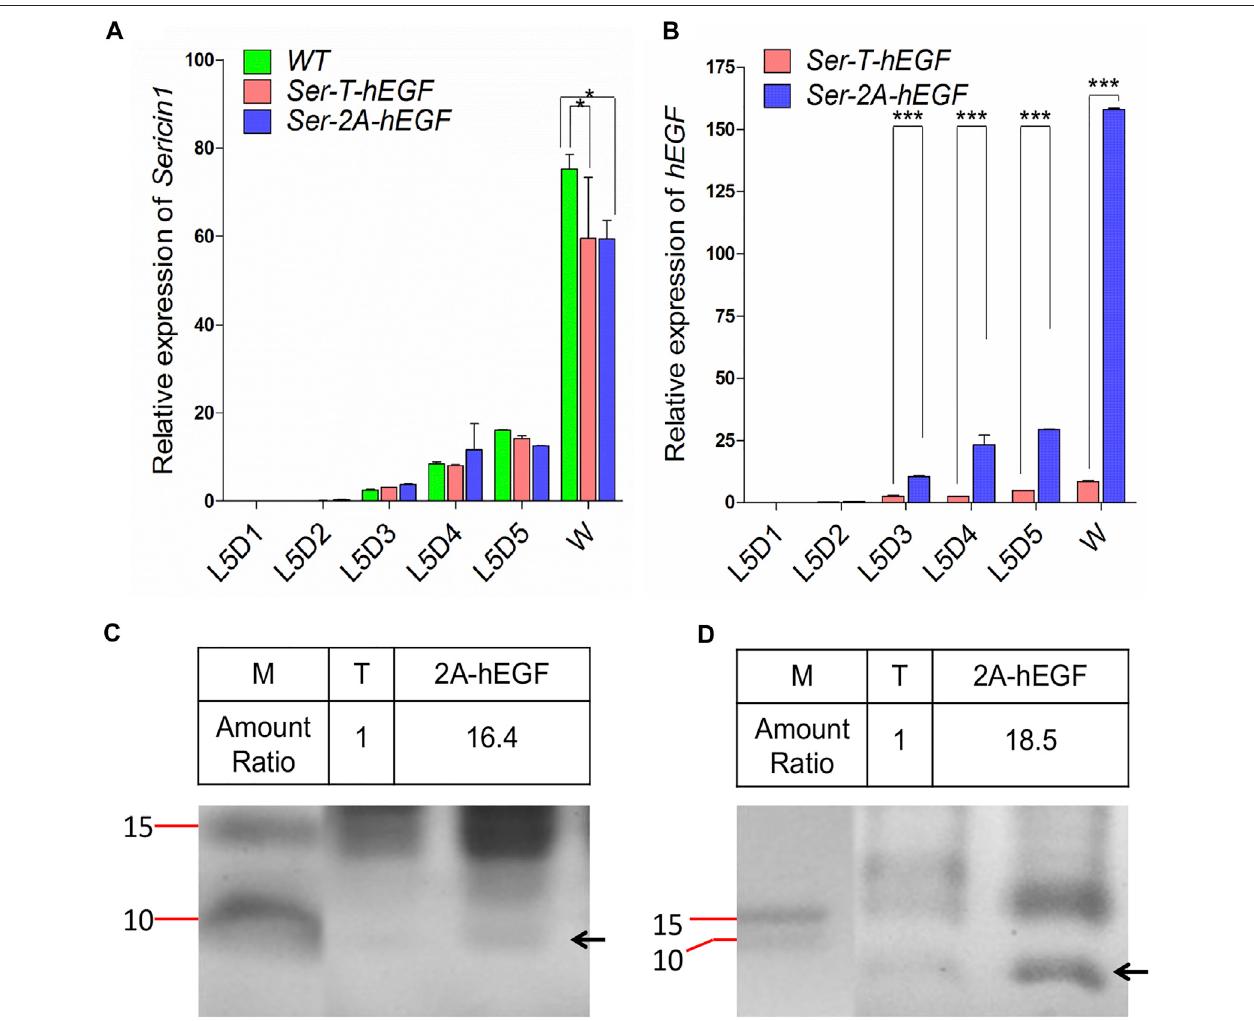
FIGURE 6 | Expression of human epidermal growth factor (hEGF) protein in the Ser – 2A – hEGF animals. (A) Comparison of hEGF transcriptional levels between Ser – T – hEGF and Ser – 2A – hEGF animals. (B) Detectionof Sericin1 in WT , Ser – T – hEGF ,and Ser – 2A – hEGF silkworms.qRT-PCRwasusedtoquantifythetranscriptional levels of Sericin1 and hEGF in A and B . The silkworm ribosome protein 49 ( Bmrp49 ) ortholog was used as the internal reference gene. Three individual replicates were usedforqRT-PCR,andtheerrorbarsrepresentthemean ± S.E.M. (C,D) CoomassiebrilliantbluestainingfortheproteinsextractedfromtheMSG(D)andcocoon (D) of Ser – T – hEGF and Ser – 2A – hEGF silkworms. The black arrows indicate hEGF protein. M, protein marker; T, Ser – T – hEGF ; 2A-hEGF, Ser – 2A – hEGF . Size of protein marker bands are